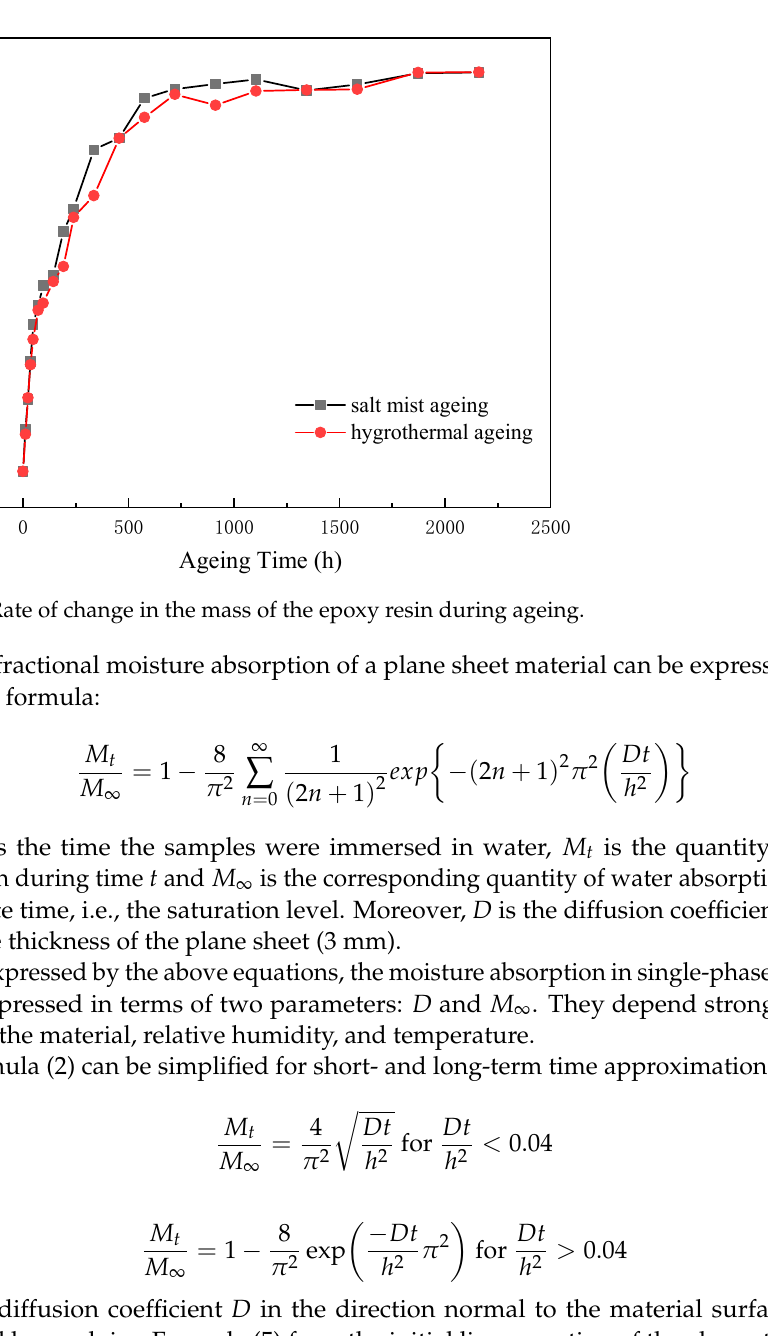
where S is the slope of the initial zone of the moisture absorption curve and M 1 and M 2 are the values of the moisture content at the arbitrary time t 1 and t 2 during the initial stage, respectively. The diffusion coefficients under the two ageing conditions are shown in Table